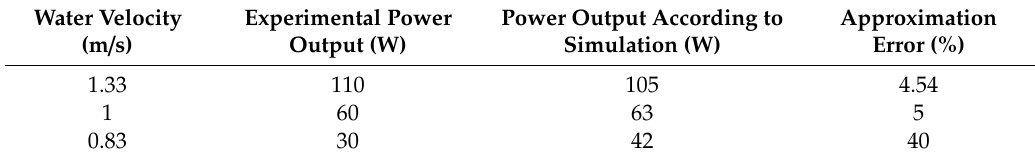
Table 2. Comparison between experimental and simulation